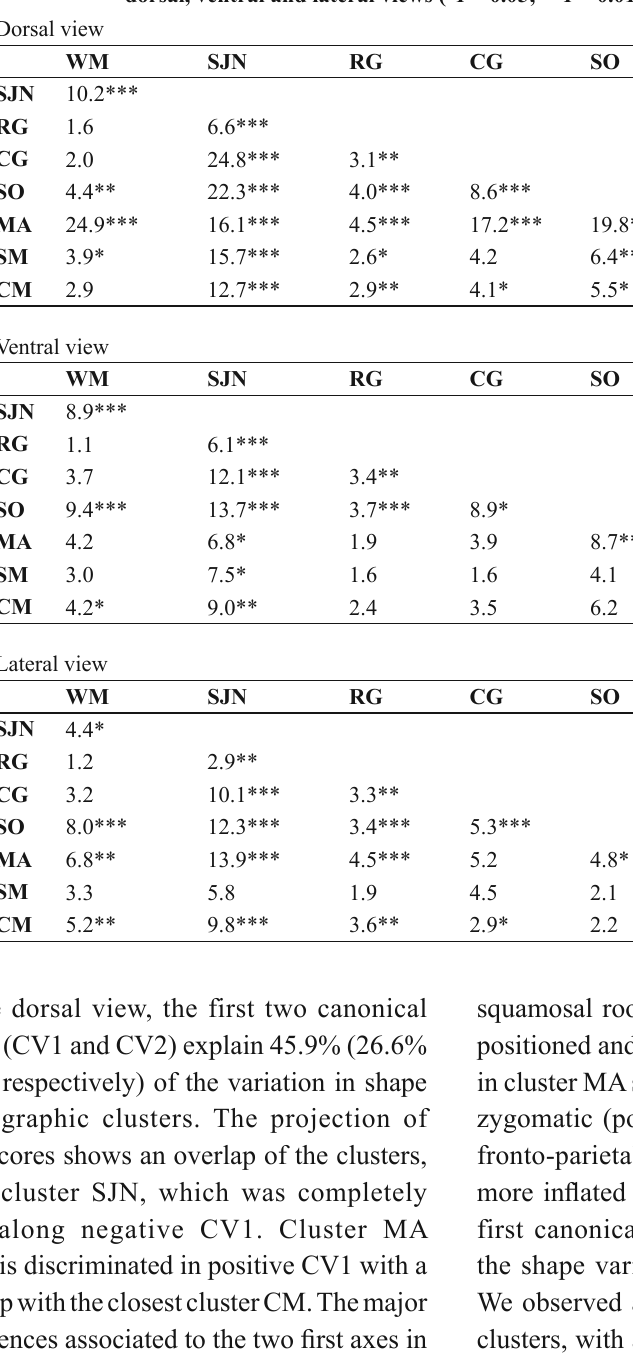
F values and signi fi cance levels of pair wise MANOVA analysis of variation in Scapteromys tumidus skull shape among eight geographic clusters in southern Brazil and Uruguay, for dorsal, ventral and lateral views (* P < 0.05; ** P < 0.01; *** P <